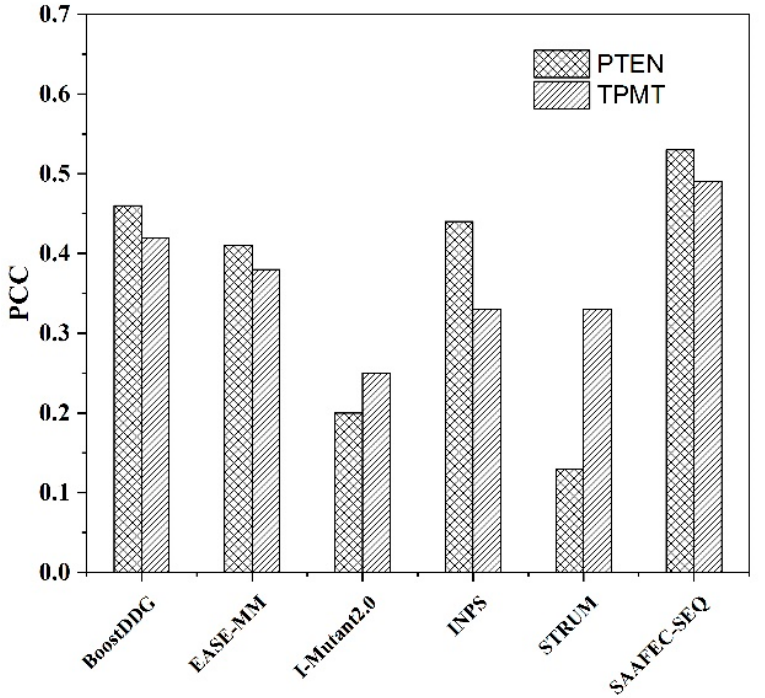
Figure 3. Performance comparison of SAAFEC-SEQ with other existing sequence-based methods on PTEN and TPMT datasets.